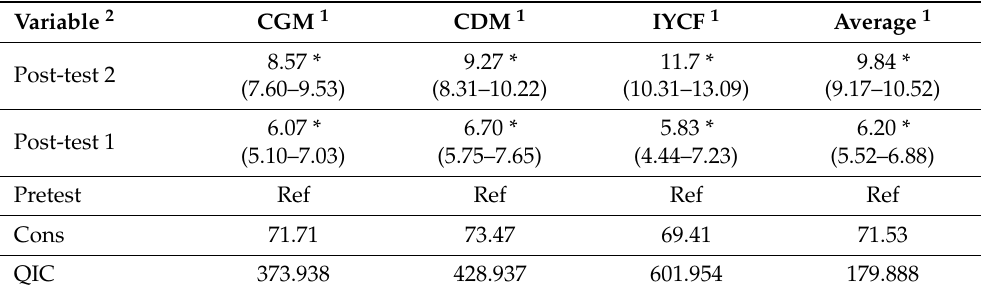
Table 3. Multivariate analysis of short course impact on cadres’ knowledge using